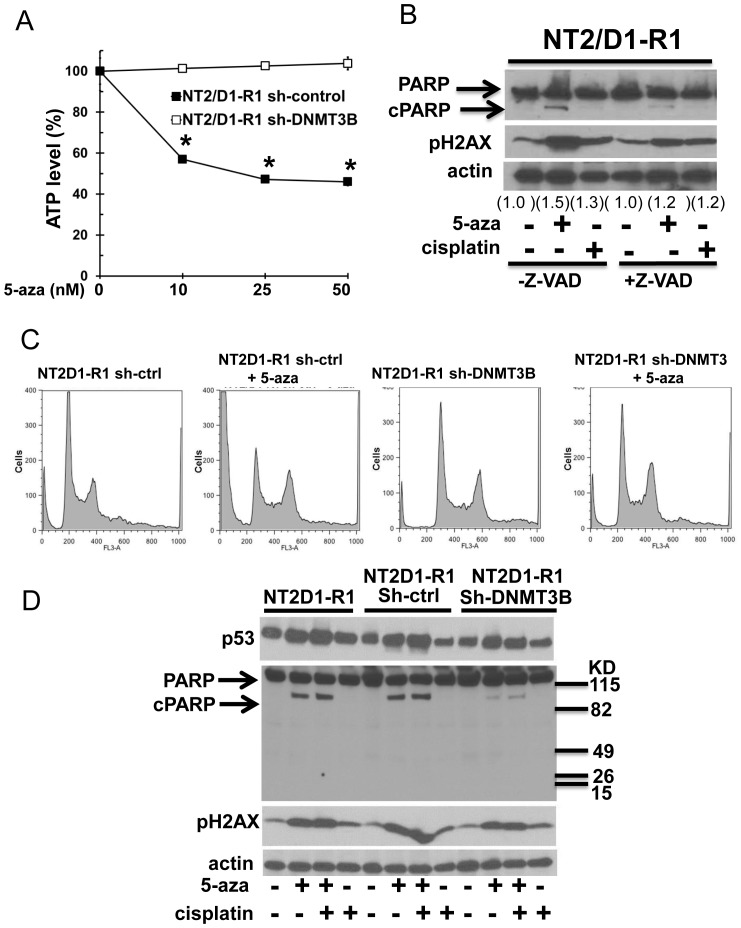
Knockdown of DNMT3B results in resistance to low-dose 5-aza downstream of DNA damage and p53 protein induction.
A, DNMT3B knockdown in NT2/D1-R1 cells leads to resistance to low-dose 5-aza. Indicated doses of 5-aza were added fresh each day for 3 days to exponentially growing cultures of NT2/D1-R1 lentiviral control cells and NT2/D1-R1 cells stably expressing a lentiviral shDNMT3B construct. Viable cell growth and survival were measured. Data was normalized to no drug treatment. Error bars (within symbols) are standard deviation. * p = <0.05 compared to untreated controls. B, Low dose 5-aza induces DNA damage in NT2/D1-R1 cells independent of apoptosis. Cells were pretreated with vehicle or 20 µM Z-VAD-FMK (z-VAD) and treated with 100 nM 5-aza or 2 µM cisplatin for 1 day prior to Western analysis. Accumulation of pH2AX is indicative of double strand breaks. The arrow labeled cPARP indicates cleaved PARP that is indicative of apoptosis. Densitometry of pH2AX normalized to actin is shown. C, DNMT3B knockdown in NT2/D1-R1 cells results in resistant to low-dose 5-aza induced cell death and G2 cell cycle arrest. Cells were treated with 10 nM 5-aza for 3 days and then assayed for cell cycle analysis. Substantial cells in subG1 are indicative of cell death. D, Knockdown of DNMT3B in NT2/D1-R1 cells inhibits low-dose 5-aza mediated cell death but not p53 protein induction or induction of DNA damage. NT2/D1-R1 cells with no lentivirus and cells treated with sh-control lentvirus and sh-DNMT3B lentivirus were treated with 10 nM 5-aza for 3 days, 1 µM cisplatin for 12 hours or the combination. Western analysis was performed for p53, PARP and pH2AX.